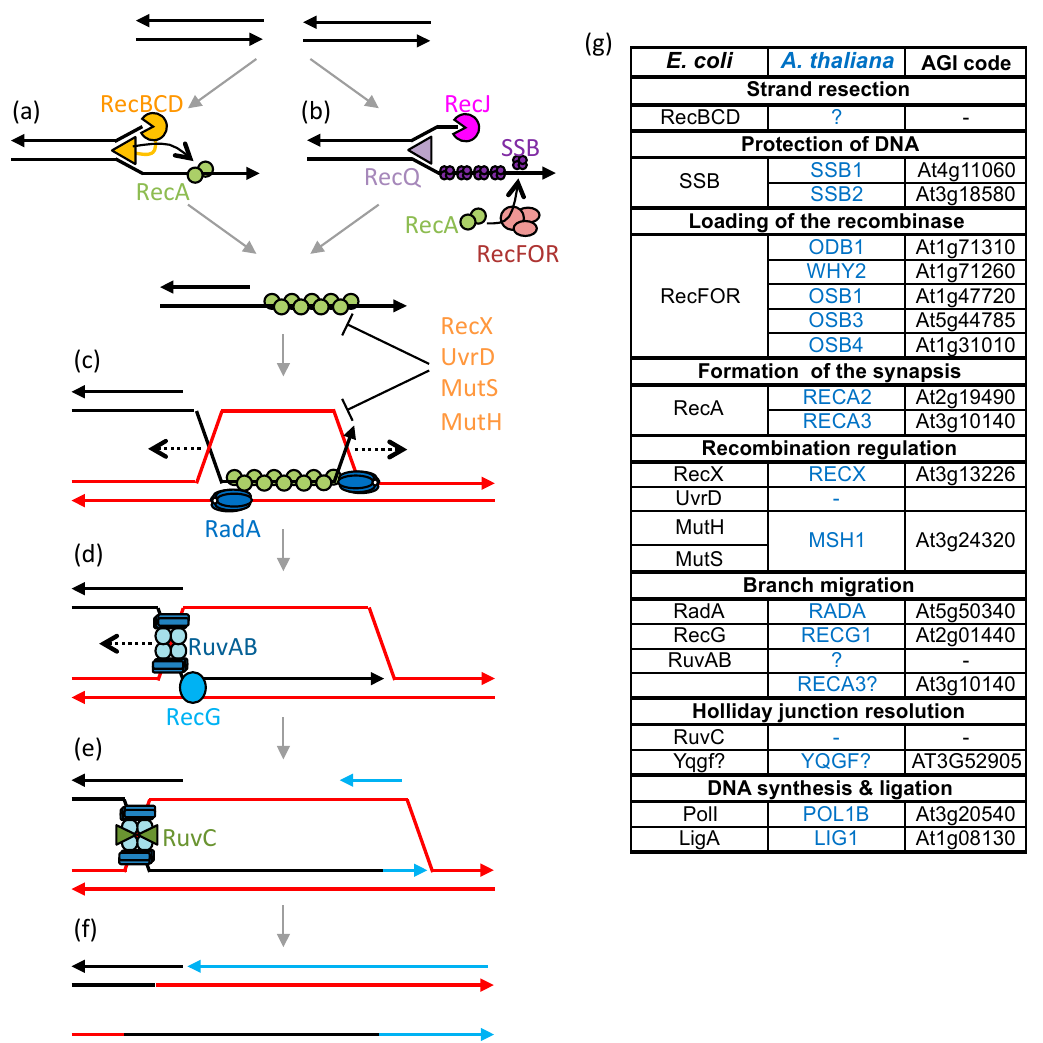
Figure 3. Different steps of bacterial homologous recombination (HR) and corresponding plant mitochondrial factors. The repair of double-strand breaks (DSBs) by HR begins with the resection of its ends. ( a ) The RecBCD pathway involves the RecBCD complex composed of two helicases and an exonuclease, and their actions lead to a single-strand DNA (ssDNA) loop region to which the RecA recombinases binds. ( b ) The alternative RecFOR pathway involves the RecQ helicase and the RecJ exonuclease that open and degrade the DNA, forming a protruding 3 ′ ssDNA end that is coated with the ssDNA-binding protein SSB. The RecFOR complex then promotes the replacement of SSB by RecA. After nucleation of RecA, the RecA-ssDNA nucleofilament is rapidly elongated and then scan for sequence homology in the genome. ( c ) When a homologous double-strand DNA (dsDNA) is found, the nucleofilament invades it and forms a three-stranded DNA structure called a D-loop. ( c , d ) Branch migration, early via RadA and later via translocases RecG and RuvAB, allows the extension of the homology region and the recruitment of the fourth strand, thus forming a Holliday junction (HJ). ( e ) The HJ is resolved, with or without a crossover, by the RuvC nuclease that is recruited by RuvAB. ( f ) A DNA polymerase synthetizes the missing DNA. ( g ) Escherichia coli factors and the probable functional homologues of Arabidopsis thaliana mitochondria.